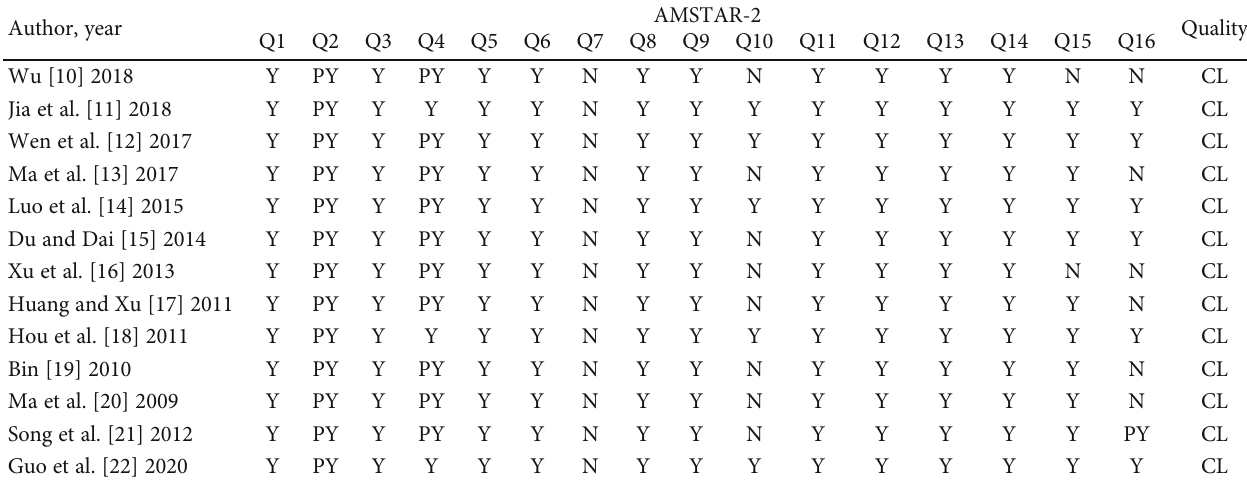
Table 3: Result of the AMSTAR-2